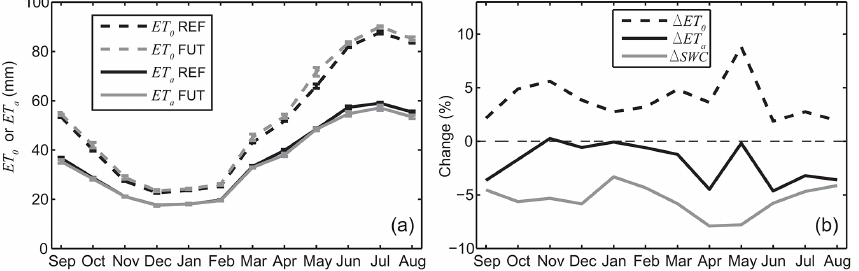
Figure 12. (a) Mean monthly ET 0 (dashed lines) and ET a (continuous lines) plotted as mean ± standard deviation of the four CMs in REF (black) and FUT (gray); (b) mean across the CMs of the relative changes of ET 0 , ET a , and SWC.